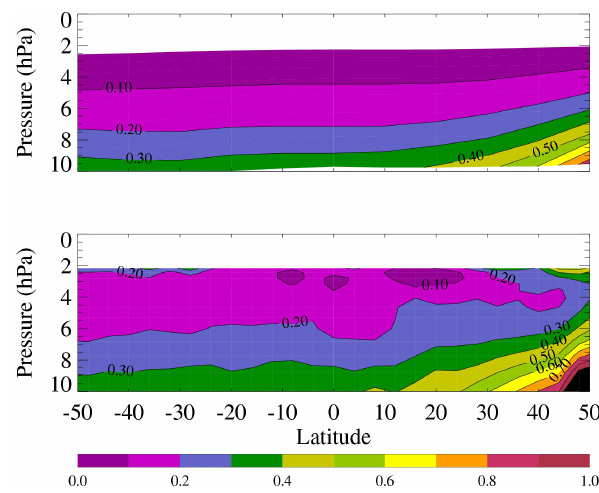
Fig. 6. HNO 3 /NO 2 ratios for February 1979 – (top) model and (bottom) LIMS V6 data. Orange-to-red colors represent high ratios, while the magenta color shows low